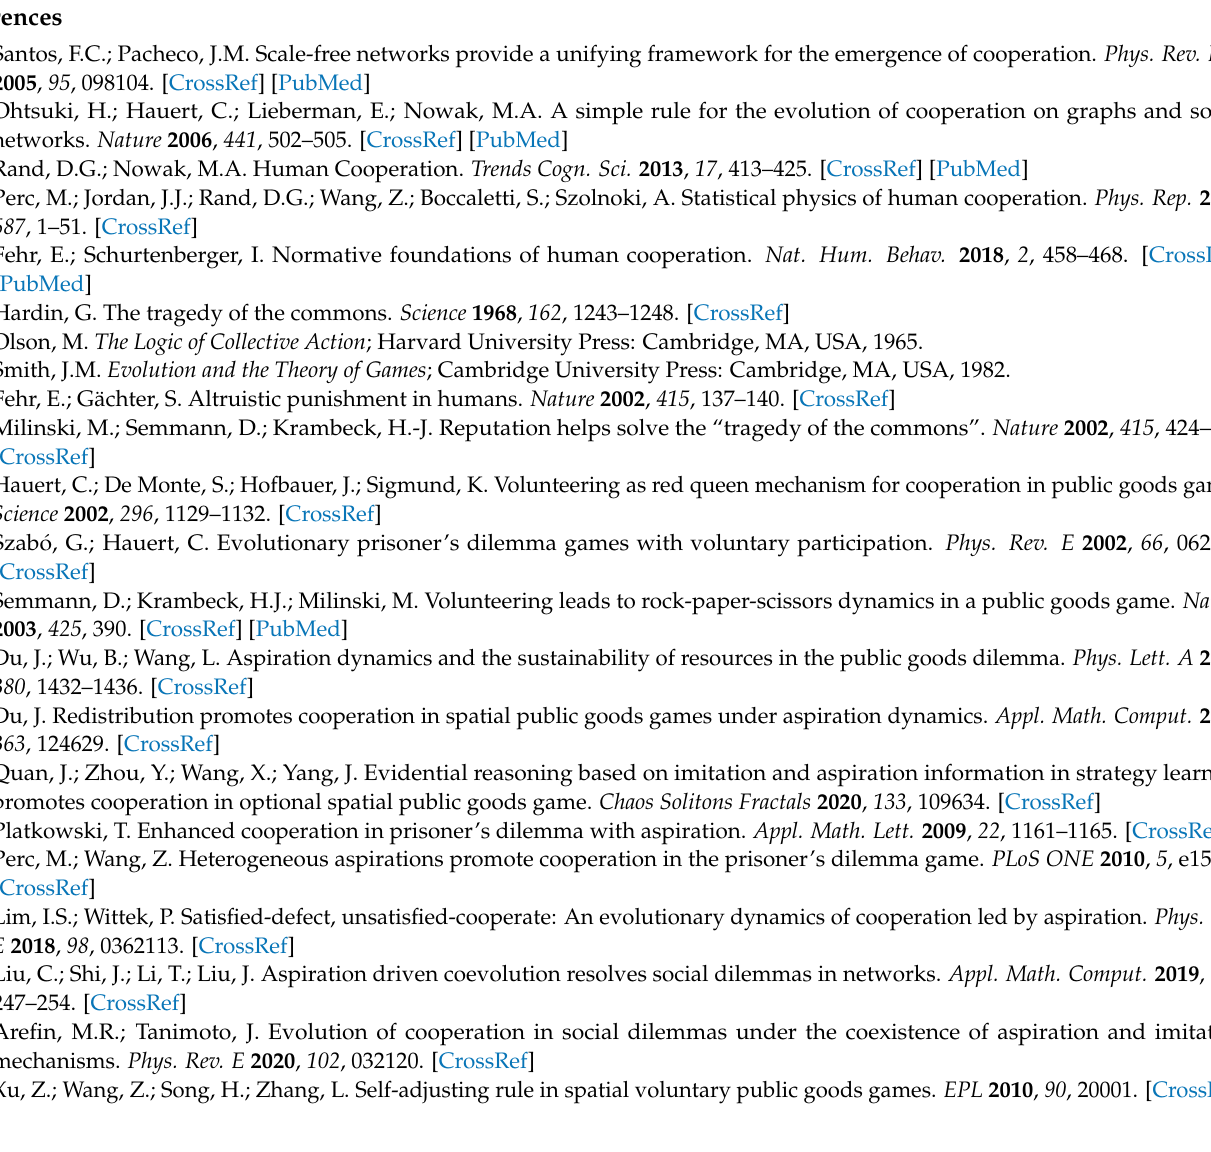
Figure A2. Fractions of cooperators (blue), defectors (red), and loners (gray) as functions of coopera- tors’ and defectors’ greediness ( β C and β D ) for ( a – c ) r = 2.5 and ( d – f ) r = 4.5. The other parameters are the same as in Figure 7.